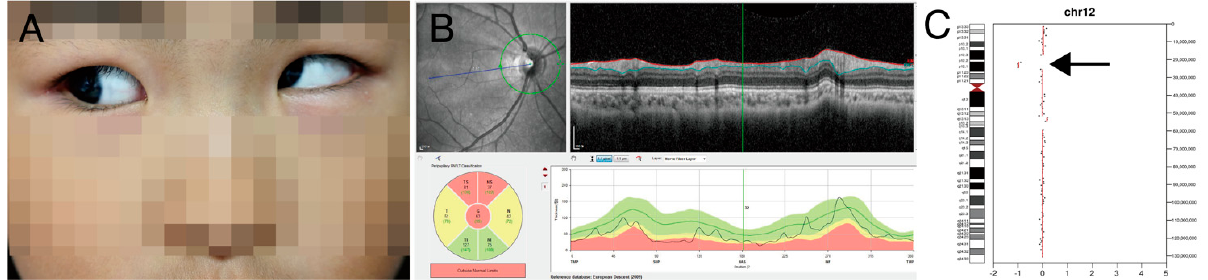
Figure 5. (P90) Chromosomal copy number variations analysis using off-target reads led to precision medicine ( A ) 8-year-old female showed strabismus and hirsutism was noted in philtrum area. ( B ) Spectral-domain optical coherence tomography showed optic nerve atrophy in the right eye. ( C ) Chromosomal 12p12 deletion was suspected by bioinformatics analysis using off-target reads (arrow). Array comparative genomic hybridization confirmed 12p.12.2p12.1 deletion. Optic nerve atrophy was thought to be related to a whole deletion of SOX5 gene. Because a whole deletion of the ABCC9 gene located nearby to the SOX5 gene was detected, monitoring of regular cardiac function was